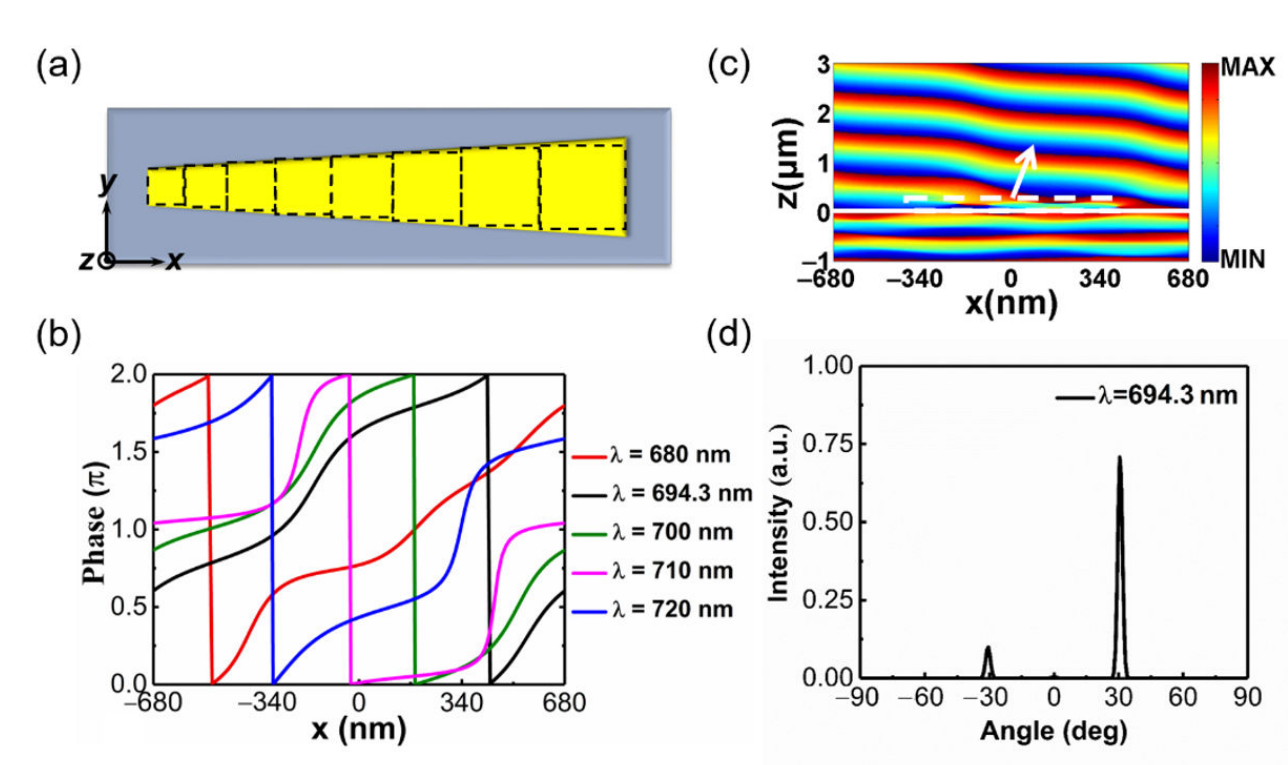
Figure 3. ( a ) Vertical view of a supercell of the quasi-continuous phase-gradient metasurface. ( b ) Phase response for y-polarized plane wave incidence with wavelengths of 680, 694.3, 700, 710 and 720 nm. ( c ) Ey field pattern in the x-z plane and ( d ) normalized far-field intensity distributions of the transmitted beams at the wavelength of 694.3